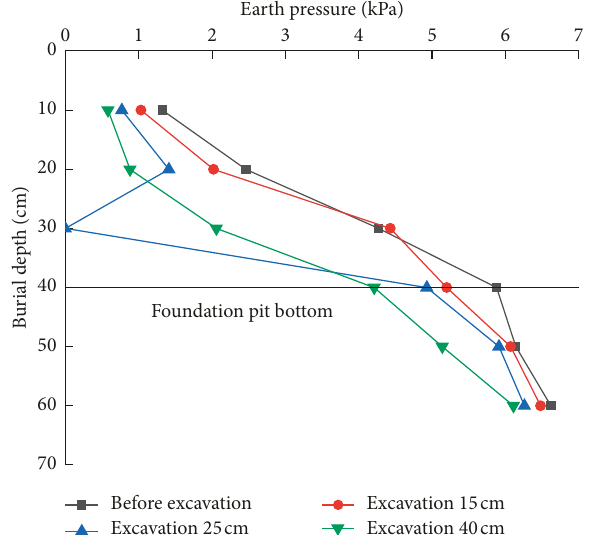
Figure 9: Earth pressure distribution curves behind piles in excavation.